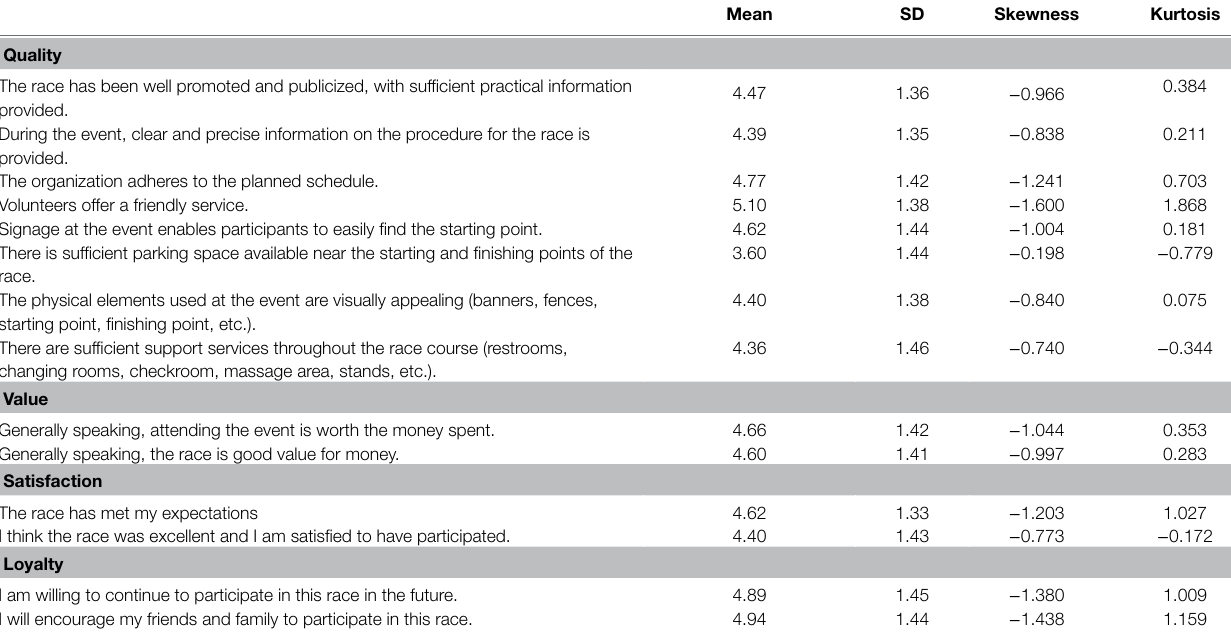
TABLE 2 | Items included in the